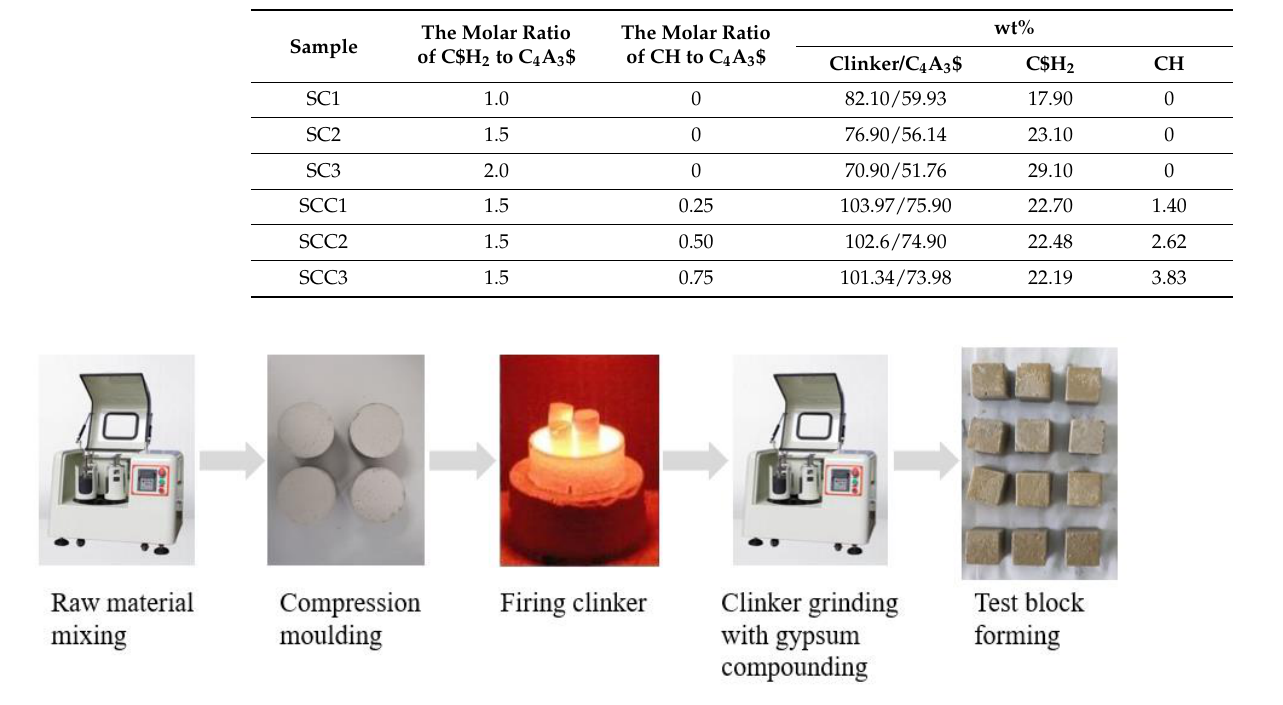
Figure 3. Experimental flowchart.